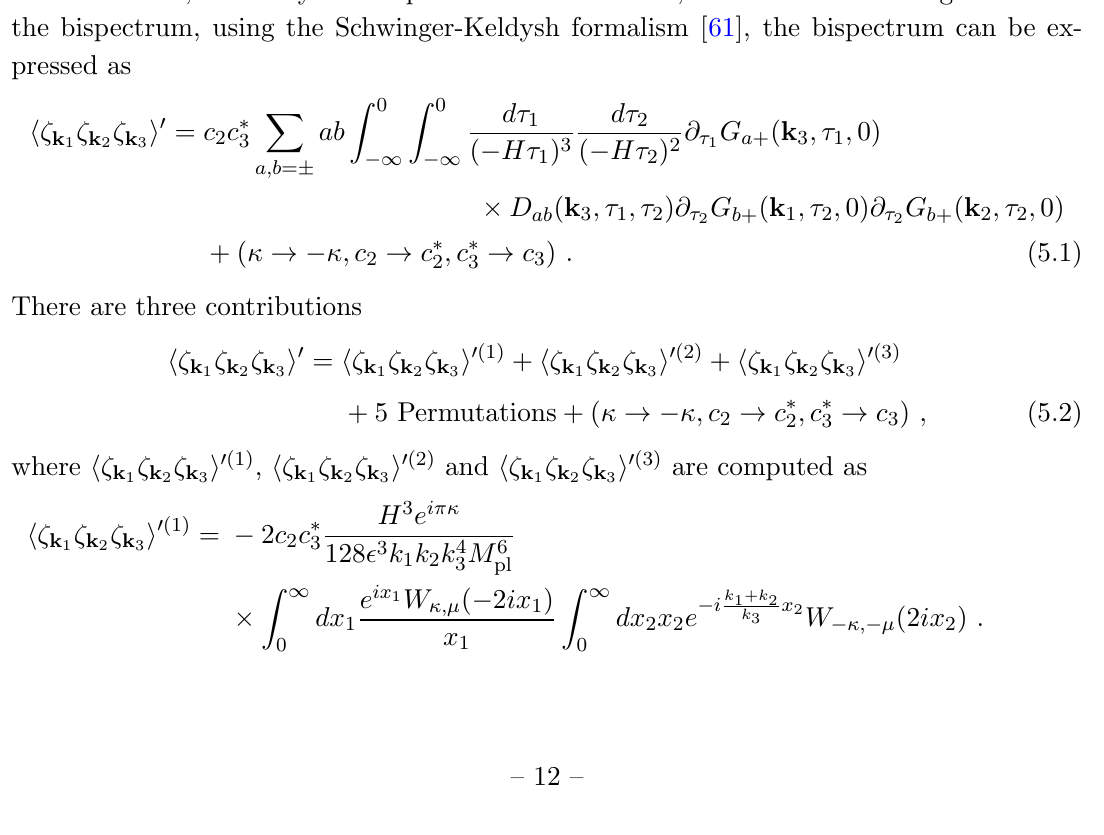
Figure 3 . The Feynman diagram we are considering for the correction to the power spectrum. This diagram involves the interaction of (cid:14)(cid:27) with the in(cid:13)aton. For the total correction, we need to include the correction from (cid:14)(cid:27) (cid:3)